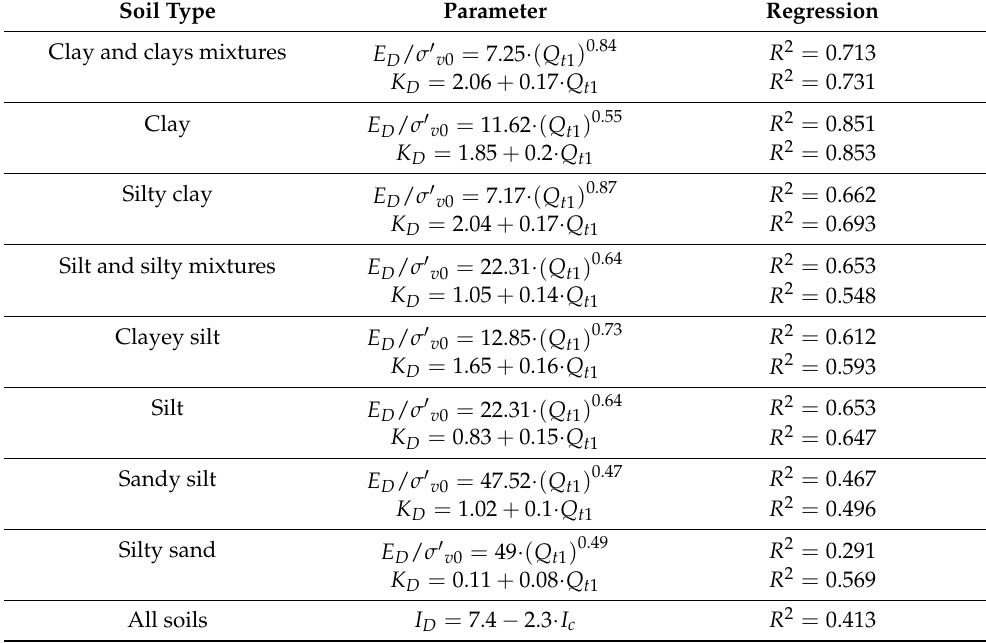
Table 4. Proposed correlations for clay-like and silty-like